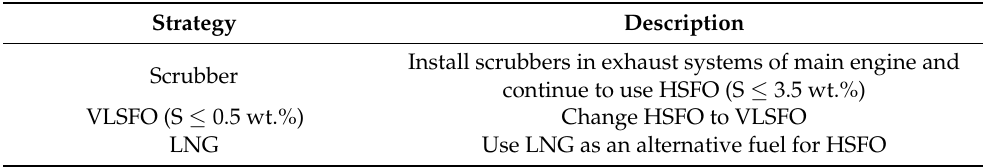
Table 1. Description of the three strategies evaluated in this study. Strategy Description Install scrubbers in exhaust systems of main engine and Scrubber continue to use HSFO (S ≤ 3.5 wt.%) VLSFO (S ≤ 0.5 wt.%) Change HSFO to VLSFO LNG Use LNG as an alternative fuel for